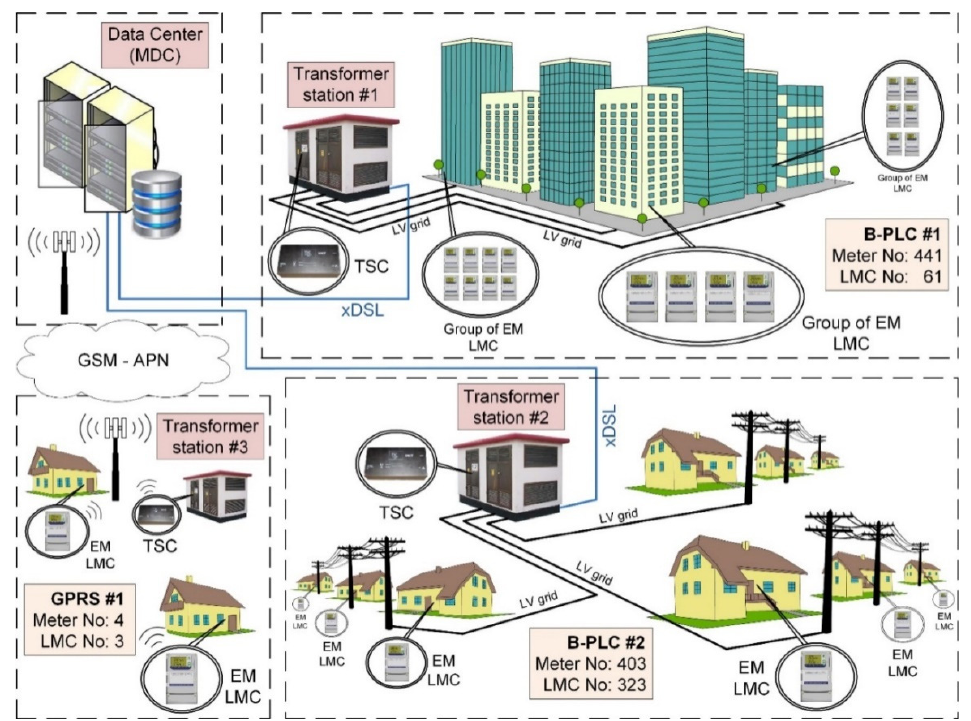
Figure 3. AMI deployment in pilot project covering tree transformer station areas with different grid topologies.